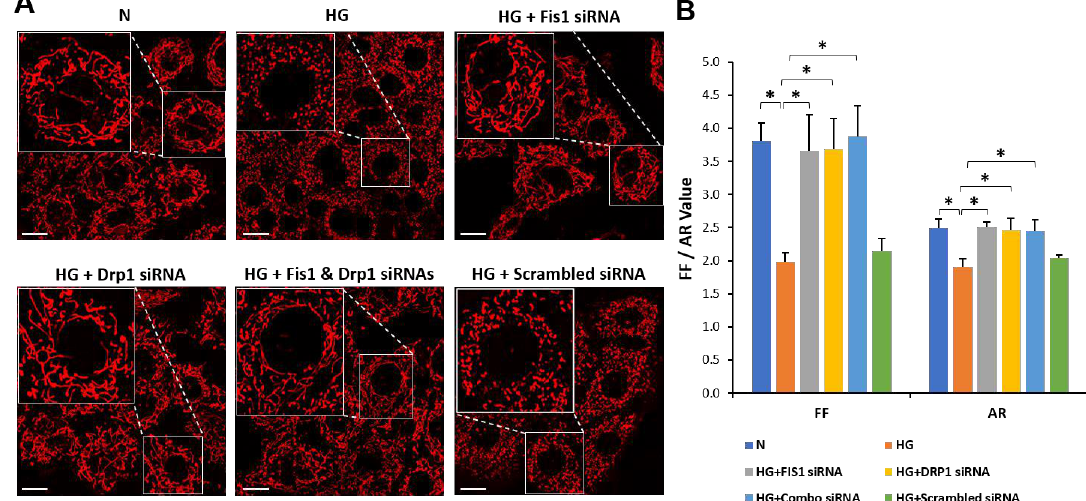
Figure 3. Reducing fission protects against HG-induced mitochondrial fragmentation. ( A ) Representative images of mitochondrial networks of RRECs grown in normal medium, HG, HG transfected with DRP1 siRNA, HG transfected with FIS1 siRNA, HG transfected with DRP1 siRNA and FIS 1 siRNA (Combo siRNA), or HG transfected with scrambled siRNA. Cells grown in HG medium or HG medium transfected with scrambled siRNA show fragmented mitochondrial networks, while cells grown in N medium or cells transfected with siRNAs exhibit tubular, elongated mitochondrial morphology. The large inset represents an enlarged view of the corresponding image (indicated by dotted lines) in the small inset in each panel. Scale bar = 20 µ m. ( B ) Graphical illustration of cumulative data shows that reducing fission genes, Drp1 and Fis1, significantly prevents HG-induced mitochondrial fragmentation. Data are expressed as mean ± SD. * p < 0.05. n = 6. FF, form factor; AR, aspect ratio.